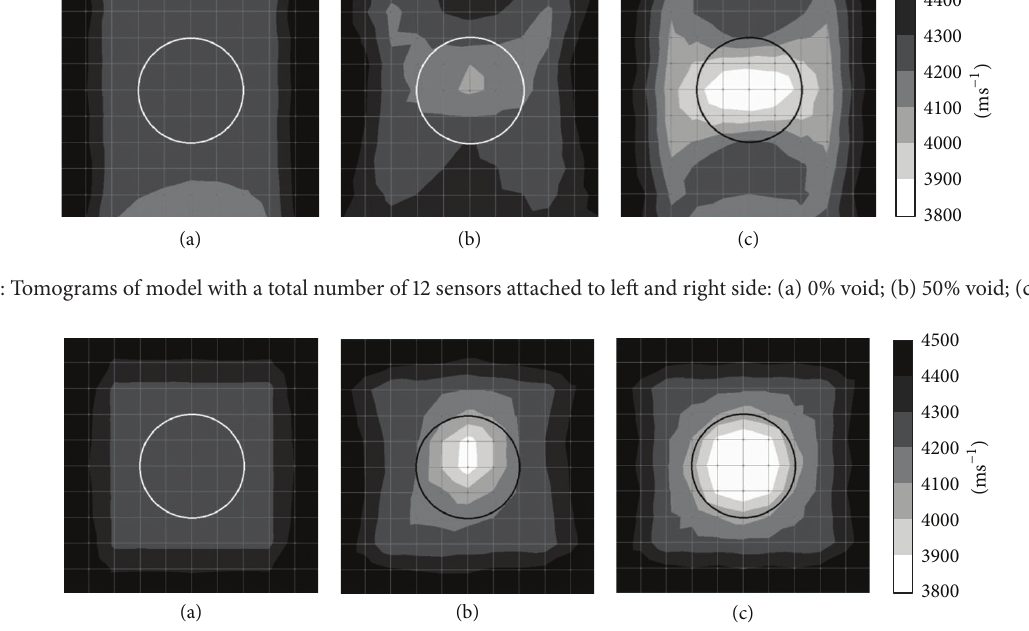
Figure 7: Tomograms of model with a total number of 20 sensors attached to four sides: (a) 0% void; (b) 50% void; and (c) 100% void.